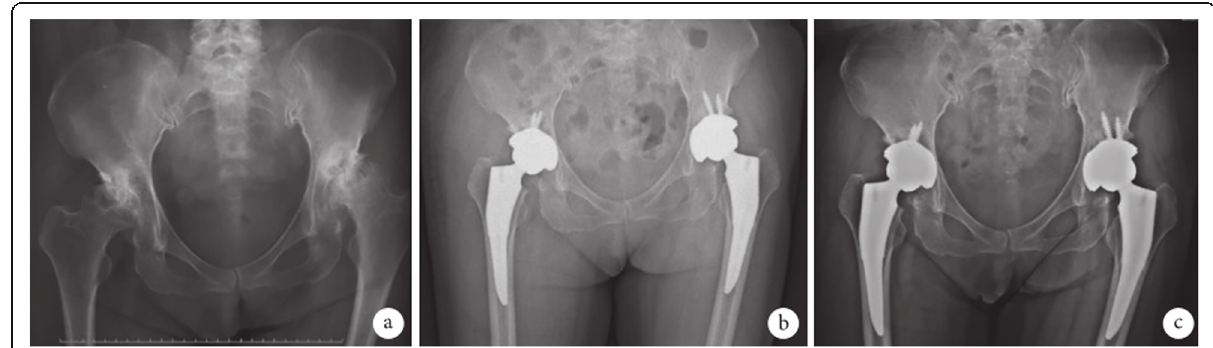
Fig. 2 X-ray films of a 62-year-old female patient with bilateral congenital hip dysplasia and secondary bilateral osteonecrosis of femoral heads in group B. a . Before operation; b . 3 months after operation; c . 18 months after